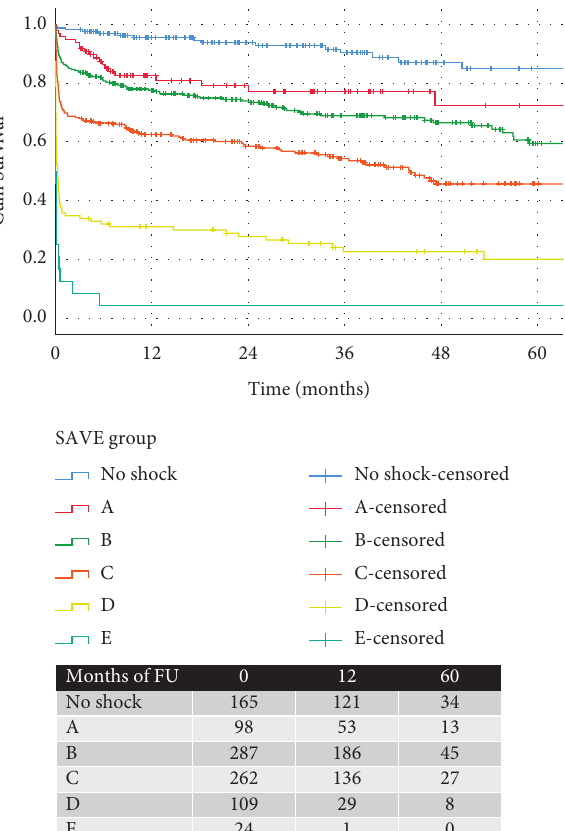
Figure 3: Kaplan–Meier curves showing 5-year survival of patients in different stages of shock, as per SAVE ACS